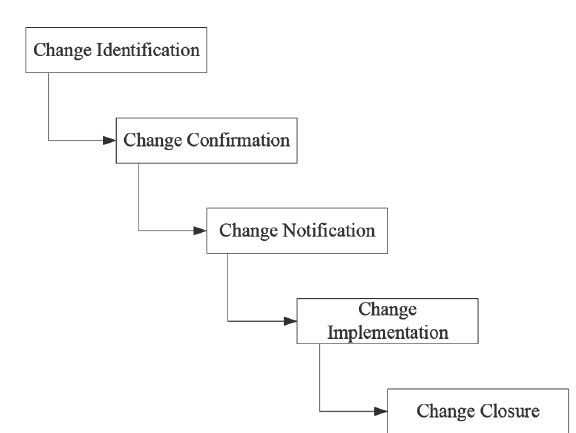
Fig. 1. Five phases of change